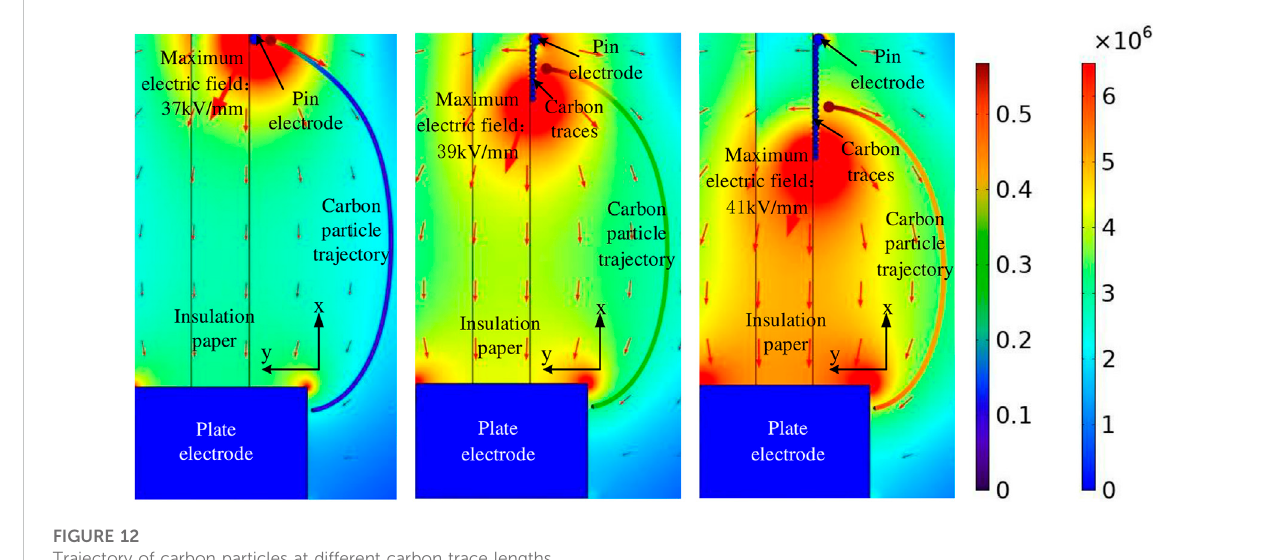
FIGURE 12 Trajectory of carbon particles at different carbon trace lengths.